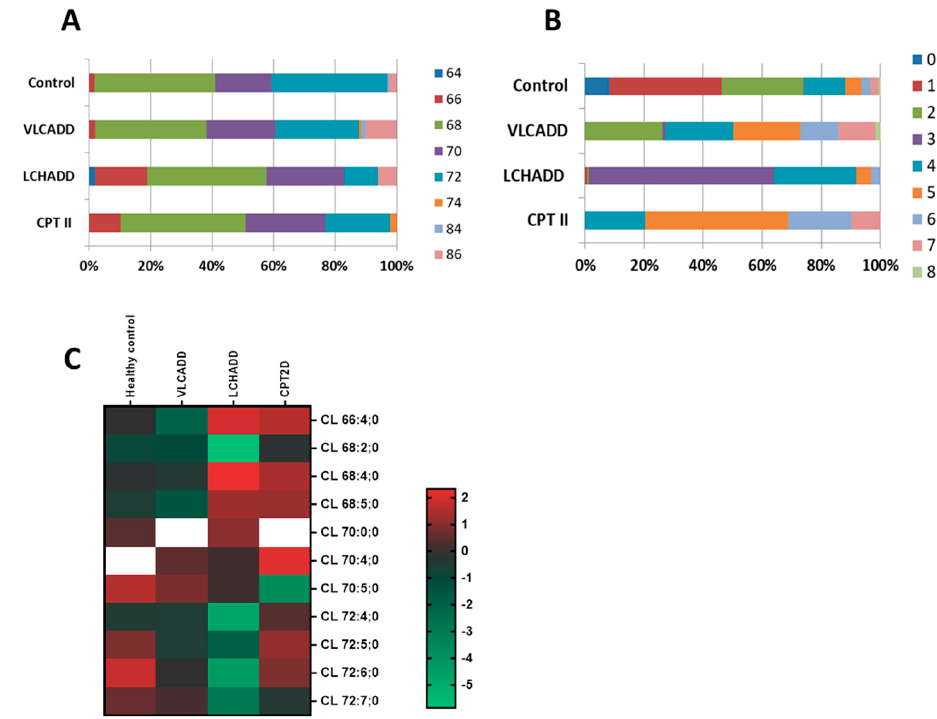
Figure 4. Disease specific alteration of cardiolipins in healthy controls and VLCADD, LCHADD and CPT2D fibroblasts. ( A ) Change of total fatty acid chain length. ( B ) Representation of the desaturation degree. ( C ) Heatmap of log2 transformed concentration of specific cardiolipin species. Concentrations of the measured fatty acid chain length are represented as percentages. Mol % sample: indicates the moles of the lipid species extracted from one sample calculated as percentage of the total amount of lipid extract.